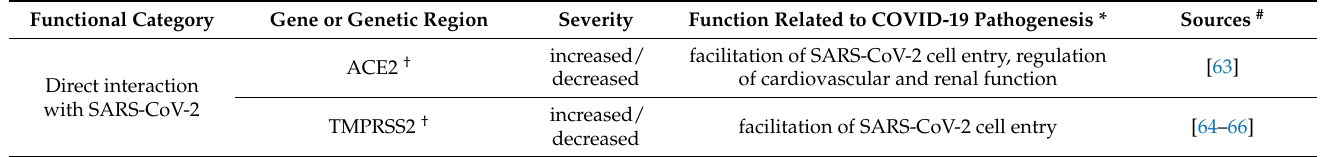
Table 1. Genes with rare or common variants that have highly supported association with COVID-19 severity. Functional Category Gene or Genetic